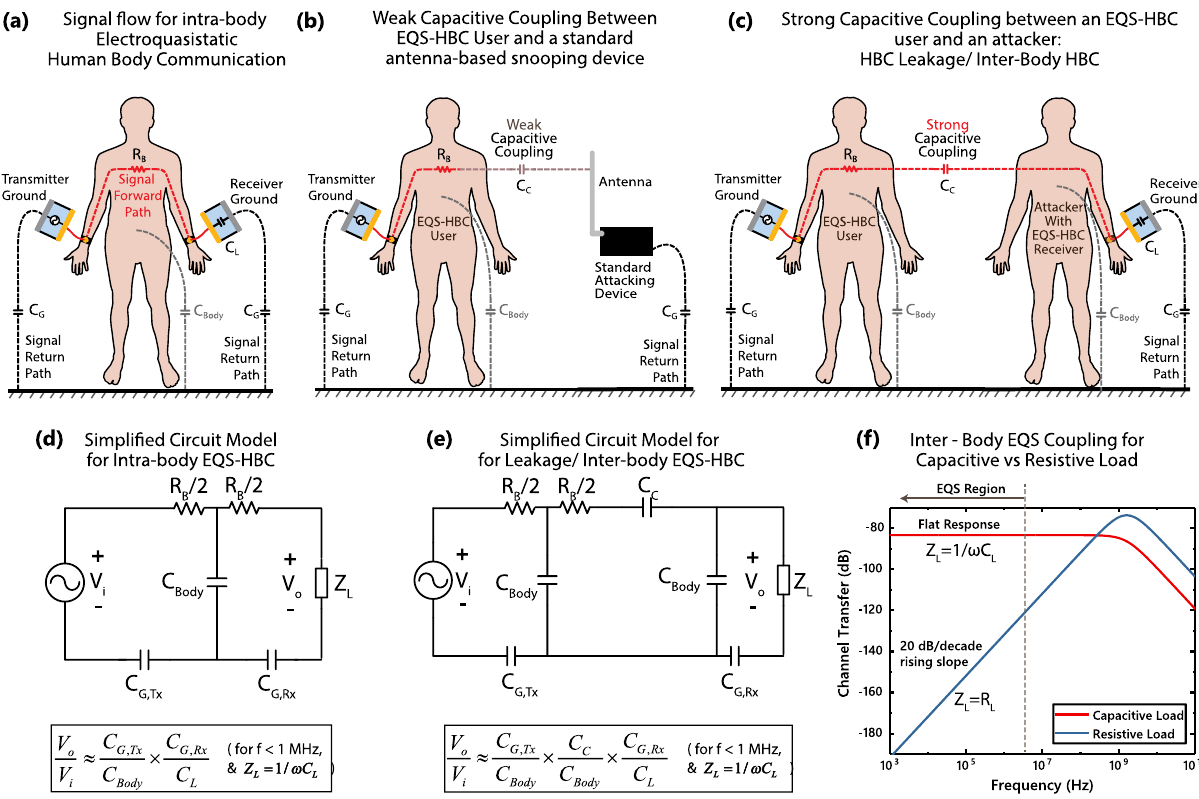
Figure 2. ( a ) Forward and return path for regular intra-body Electro-quasistatic Human Body communication (EQS-HBC). Forward path is formed through the human body, while the return path is formed through parasitic capacitances C G , Tx and C G , Rx with environment. ( b ) Weak Capacitive coupling between an EQS-HBC user and an antenna, ensuring minimal leakage pick-up by that antenna. This implies minimal interference and maximum security towards antenna based devices. ( c ) Strong capacitive coupling, C C between two human bodies pose the question of inter-body signal leakage for EQS HBC. This can potentially allow the 2nd user, the attacker, to sniff EQS HBC signals from the 1st user. If the 2nd person is just a regular user of HBC, the capacitive coupling can cause interference between the EQS HBC Signals from the two bodies. ( d ) Simplified circuit model for regular intra-body HBC of Fig. 2a, and approximate expression for channel loss. ( e ) Simplified circuit model for inter-body HBC or HBC leakage, from Fig. 2b, and approximate expression for channel loss. The extra term C C / C Body represents an additional loss from inter-body coupling. ( f ) Comparison of inter-body EQS coupling for capacitive vs Resistive load at the receiver’s end. For capacitive load, the low-frequency region is a flat-band response. For resistive load, the response is a 20 dB/decade rising EQS inter‑body coupling. In capacitive EQS-HBC, signal electrodes of the transmitting and receiving devices are connected to a human body, while the ground electrodes are left floating. As shown in Fig. 2a, the human body forms the forward path of communication 13 , while the return path is formed by parasitic capaci- tance between the earth’s ground and the transmitter and receiver ground planes 14 ( C G , Tx and C G , Rx respectively). This parasitic return path is key in capacitive EQS-HBC operation, as low-frequency EQS operation makes the system analogous to an electrical circuit (2d)—where a closed loop must be present between the transmitter and the receiver. The impedance of the return path capacitances are much higher compared to the forward path resistance R B for frequencies < 1 MHz 14,15 , and when operated in that frequency region, most of the potential drop happens across C G , Tx and C G , Rx . The fact that wavelength of signals are much larger than the human body dimensions, leaves the entire human body roughly at the same quasistatic electric potential—letting us incorpo- rate the body as a single point node in the circuit model and introduce the idea of inter-body coupling simply in terms of a lumped version of a distributed coupling capacitance C C , as shown in fig. 2c. As the primary EQS- HBC user’s body stays at a constant EQS potential at a given point in time, this inter-body capacitance C C can couple part of that potential to a second person’s body, and can potentially be picked up by an EQS-HBC device being used by the same person. This inter-body coupling can affect EQS-HBC in two different ways, namely security and interference: